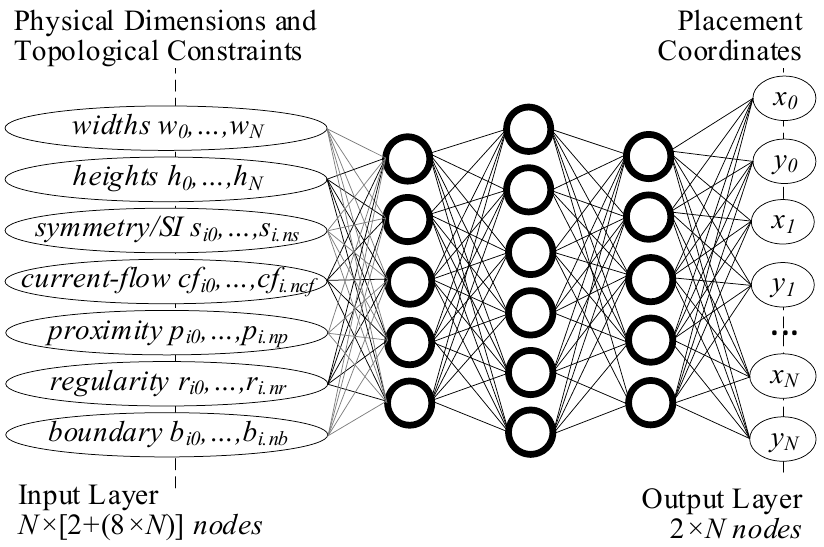
Figure 1. ANN architecture used to solve the map from the physical dimensions and topological constraints to the placement coordinates. 𝑁 represents the maximum number of circuit devices supported by the model.